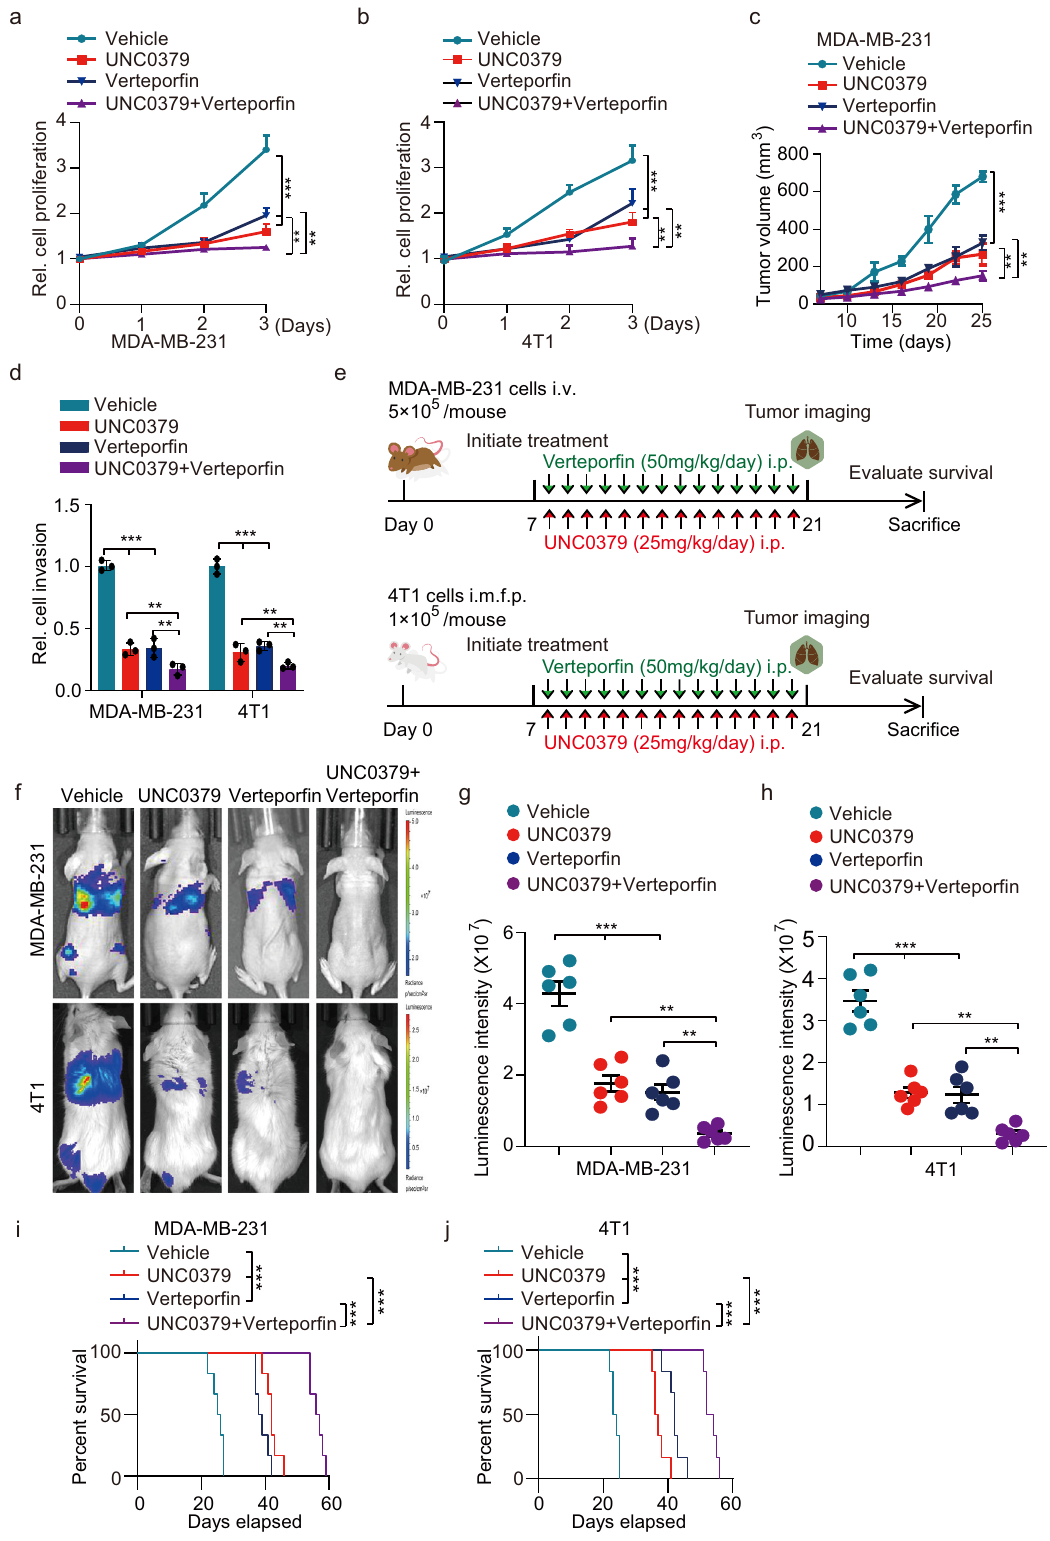
a concomitant upregulation in KMT5A, SNIP1K301me1, and MARK4 expression depict poor prognostic factors for metastatic TNBC patients. (Fig. 8g). In addition, loss of KMT5A catalytic activity by KMT5A Methylation has evolved as a common posttranslational depletion or KMT5A-selective inhibitor combined with YAP modi fi cation, regulating various non-histone proteins 14 – 17,41 . signaling inhibition impedes breast cancer progression using a mouse xenograft model of breast cancer metastasis. Furthermore, SNIP1 has been identi fi ed as a transcription repressor for the NATURE COMMUNICATIONS| (2022) 13:2192